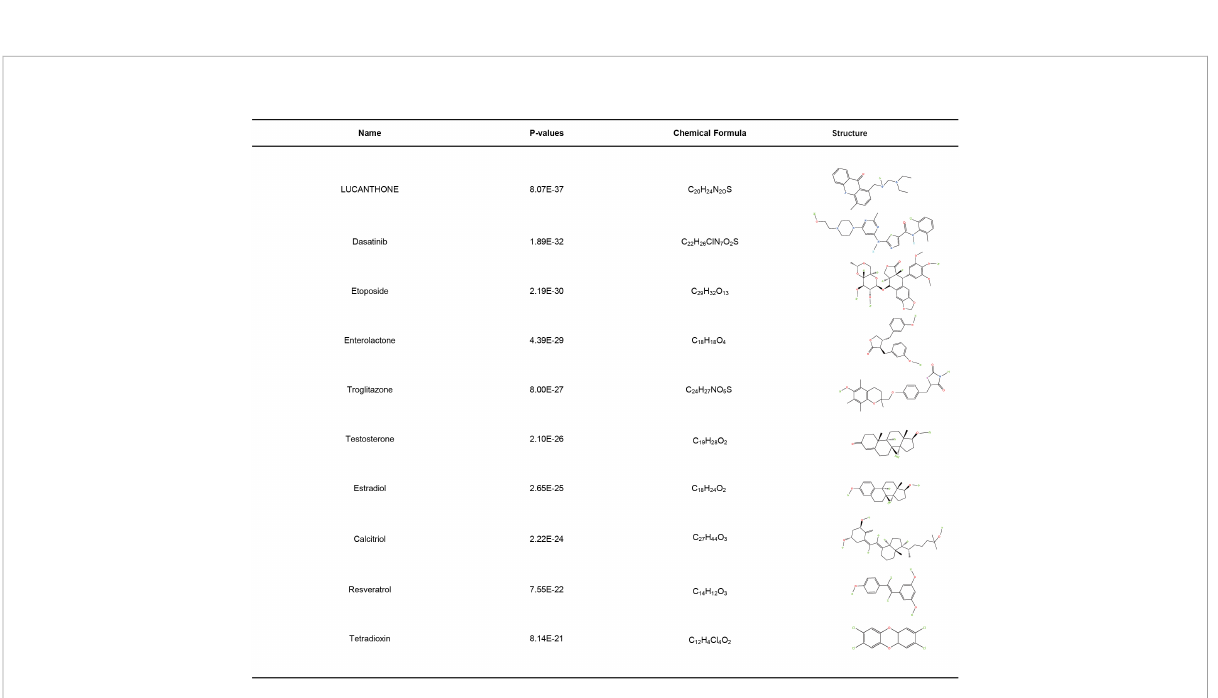
FIGURE 8 Identi fi cation of potential